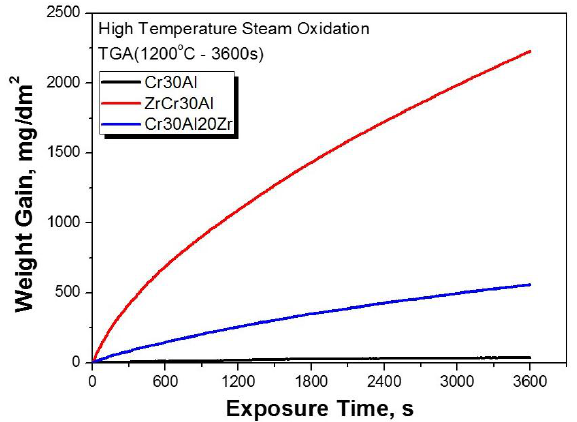
Figure 8. Oxidation behavior of Cr-30%Al cast alloys with and without Zr after the steam oxidation test at 1200 °C for 1 h (Zr alloy containing Cr and Al is also compared for reference)